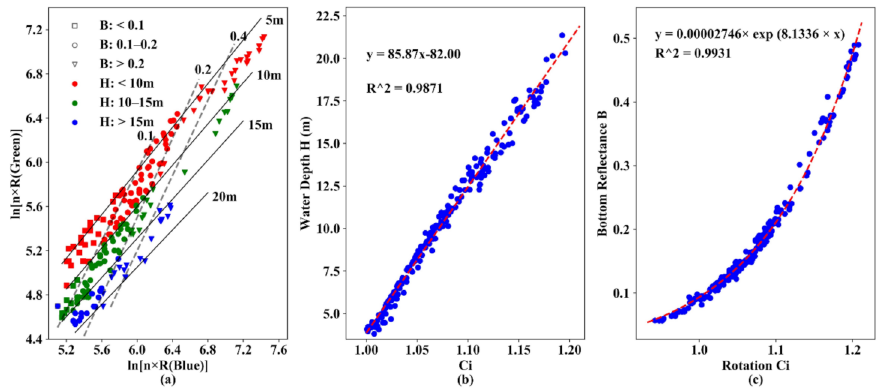
Figure 7. SIPs on WorldView-2: ( a ) Inversion results of water depth H and bottom reflectance B using the LR-S model. ( b ) Fitting curve of C i and H . ( c ) Exponential fitting curve of C (cid:48)